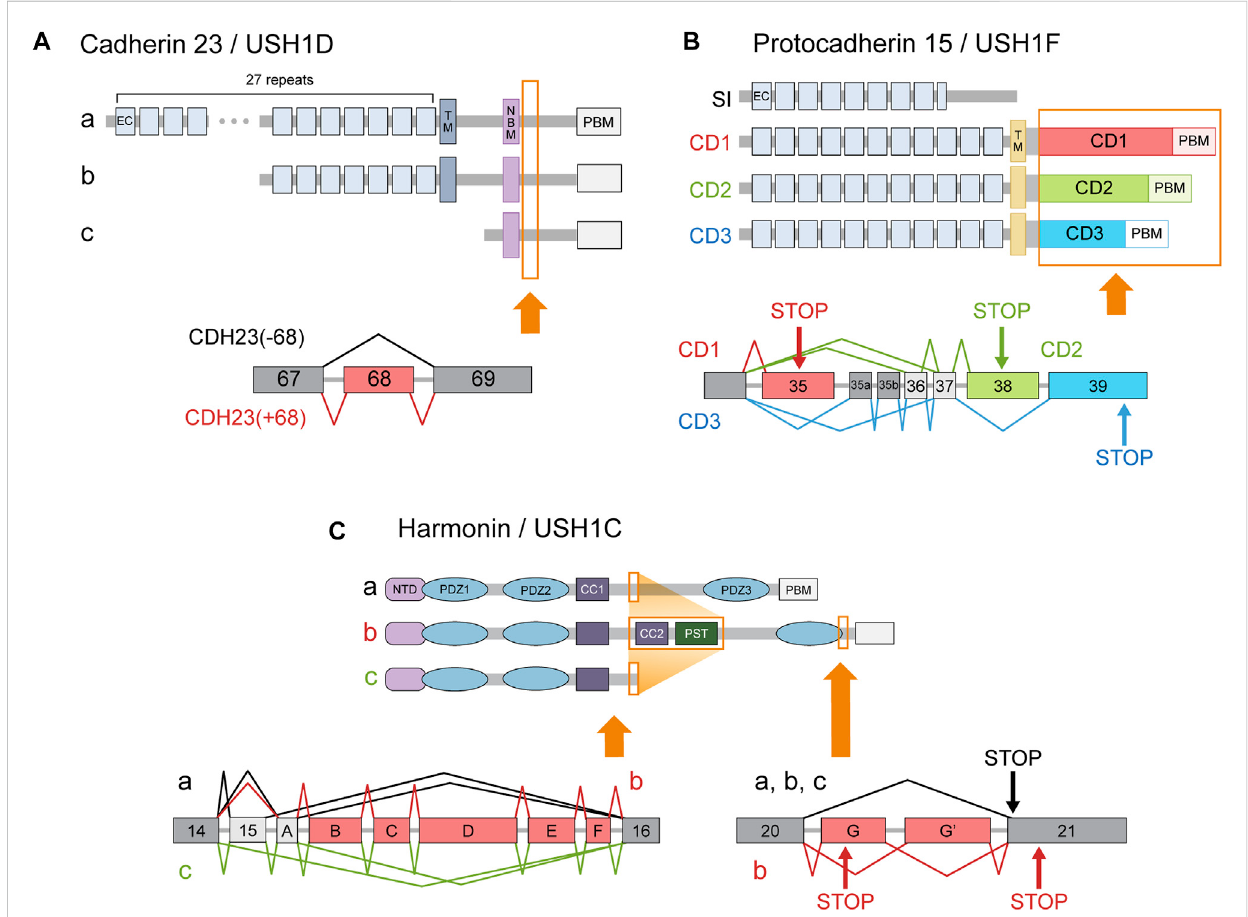
FIGURE 3 Usher gene splice variants. The major classes of Usher protein isoforms and the AS events responsible for producing them. Protein regions affected by AS are indicated in orange boxes. In the transcript diagrams, the different colors indicate different splice variant classes. Exons (or more generally, transcript regions) selectively utilized in a certain class are indicated with corresponding colors. Dark gray boxes represent constitutively included exons, while light gray boxes denote alternative exons that do not belong to a single isoform class. Arrows labeled ‘ STOP ’ indicate stop codons speci fi c to the splice variant class of the corresponding color. (A) Cadherin 23 isoform classes a, b, c are produced by utilization of alternative promoters. All three types of transcripts can either include or exclude exon 68. (B) Splice variants of protocadherin 15 are classi fi ed into 4 categories according to their cytoplasmic domains. Although AS can also affect the number of EC repeats, 11 repeats are usually assumed to comprise the standard extracellular domain. (C) Splice variants of harmonin are divided into three classes — a, b, and c — according to the arrangement of the functional domains in